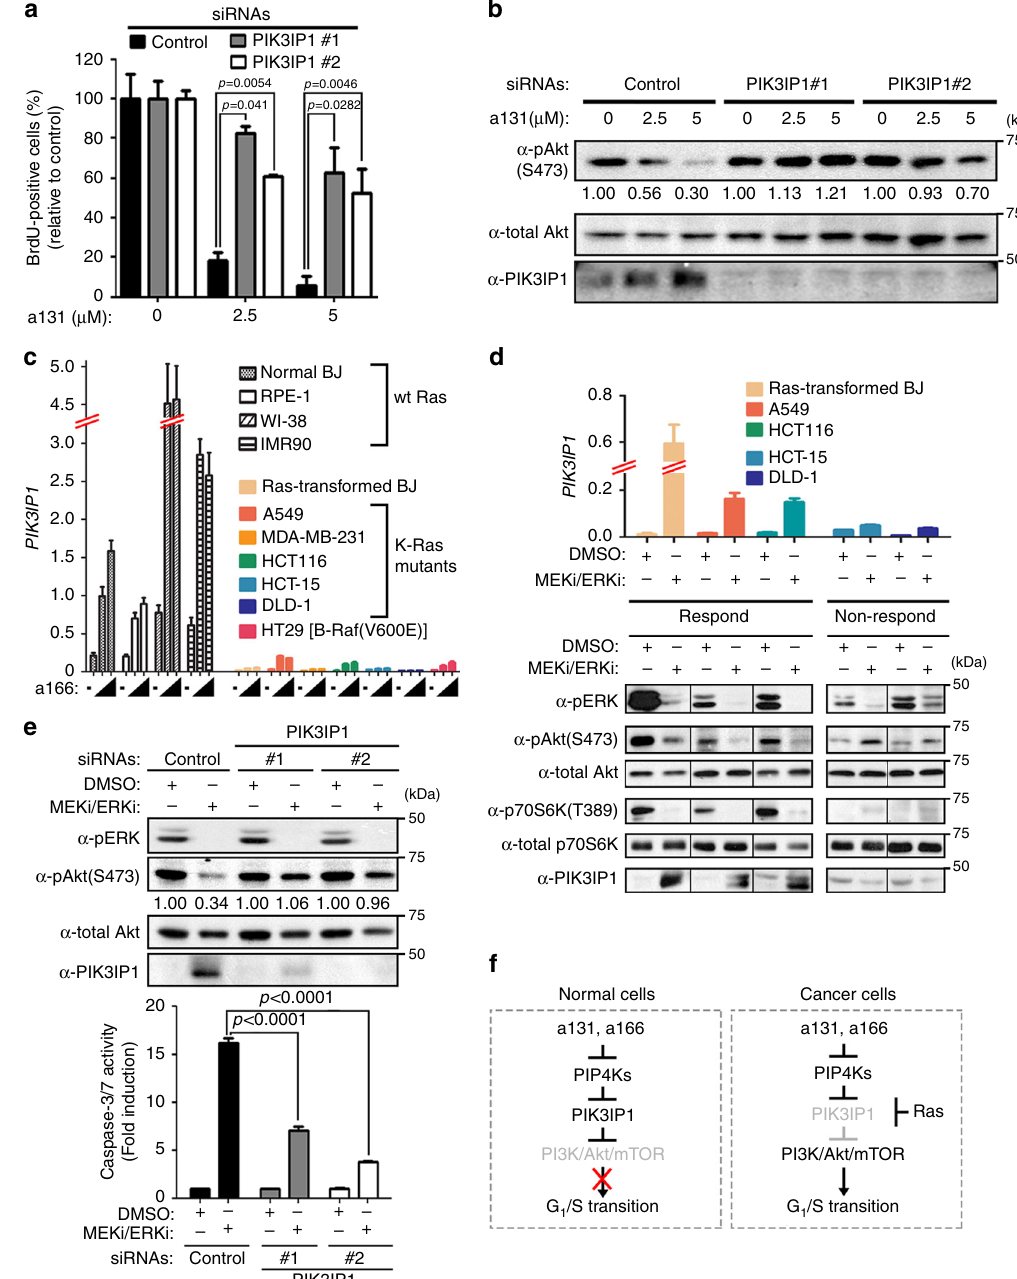
Fig. 5 The high MAPK activity suppresses PIK3IP1 in human cancers. a , b BrdU incorporation ( n = 3) ( a ) and immunoblot analysis ( b ) of normal BJ cells transfected with indicated siRNAs for 48 h and treated with a131 for additional 24 h. c qRT-PCR analysis of PIK3IP1 expression. Various normal and Ras- mutant cancer cell lines were treated with a166 at 0, 2.5, and 5 µ M for 24 h. Mean values ± S.D. ( n = 3). d qRT-PCR analysis of PIK3IP1 expression (top) and immunoblot analysis (bottom) of Ras-transformed and Ras-mutant cells treated with MEK inhibitor U0126 (10 µ M) and ERK inhibitor SCH722984 (1.2 μ M) for 24 h. e Immunoblot analysis (top) and caspase-3/7 activation (bottom, n = 3) of HCT116 cells transfected with indicated siRNAs for 48 h and treated with U0126 (10 μ M) and SCH722984 (1.2 µ M) for additional 24 h. f Schematic model of cross-talk between Ras/Raf/MEK/ERK and PI3K/Akt/mTOR pathway via Ras ˧ PIK3IP1 ˧ PI3K signaling network for cancer cell proliferation. Where indicated, relative ratios of phosphorylated/total levels of Akt and p70S6K are shown compared with DMSO. b , d , e Representative immunoblots shown ( n = 3). Where indicated, two-tailed unpaired t tests were performed to determine the statistical signi fi